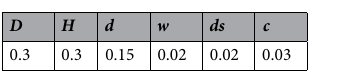
Table 1. Geometry details of a stirred vessel